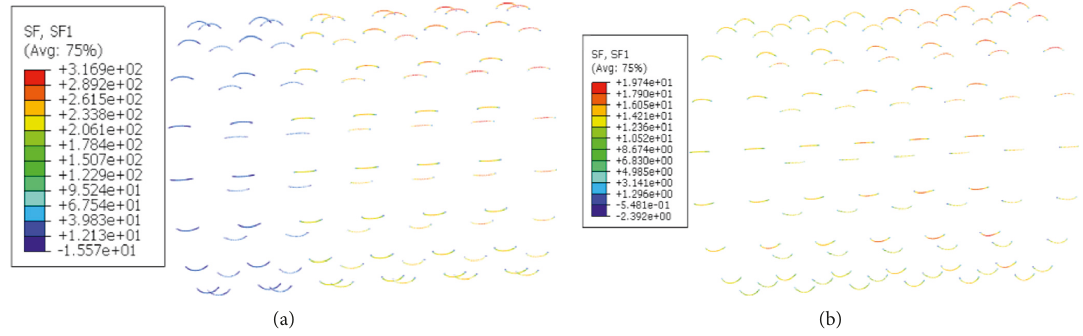
Figure 17: Tension diagram of bolt. Water head difference of (a) 18 m and (b) 0